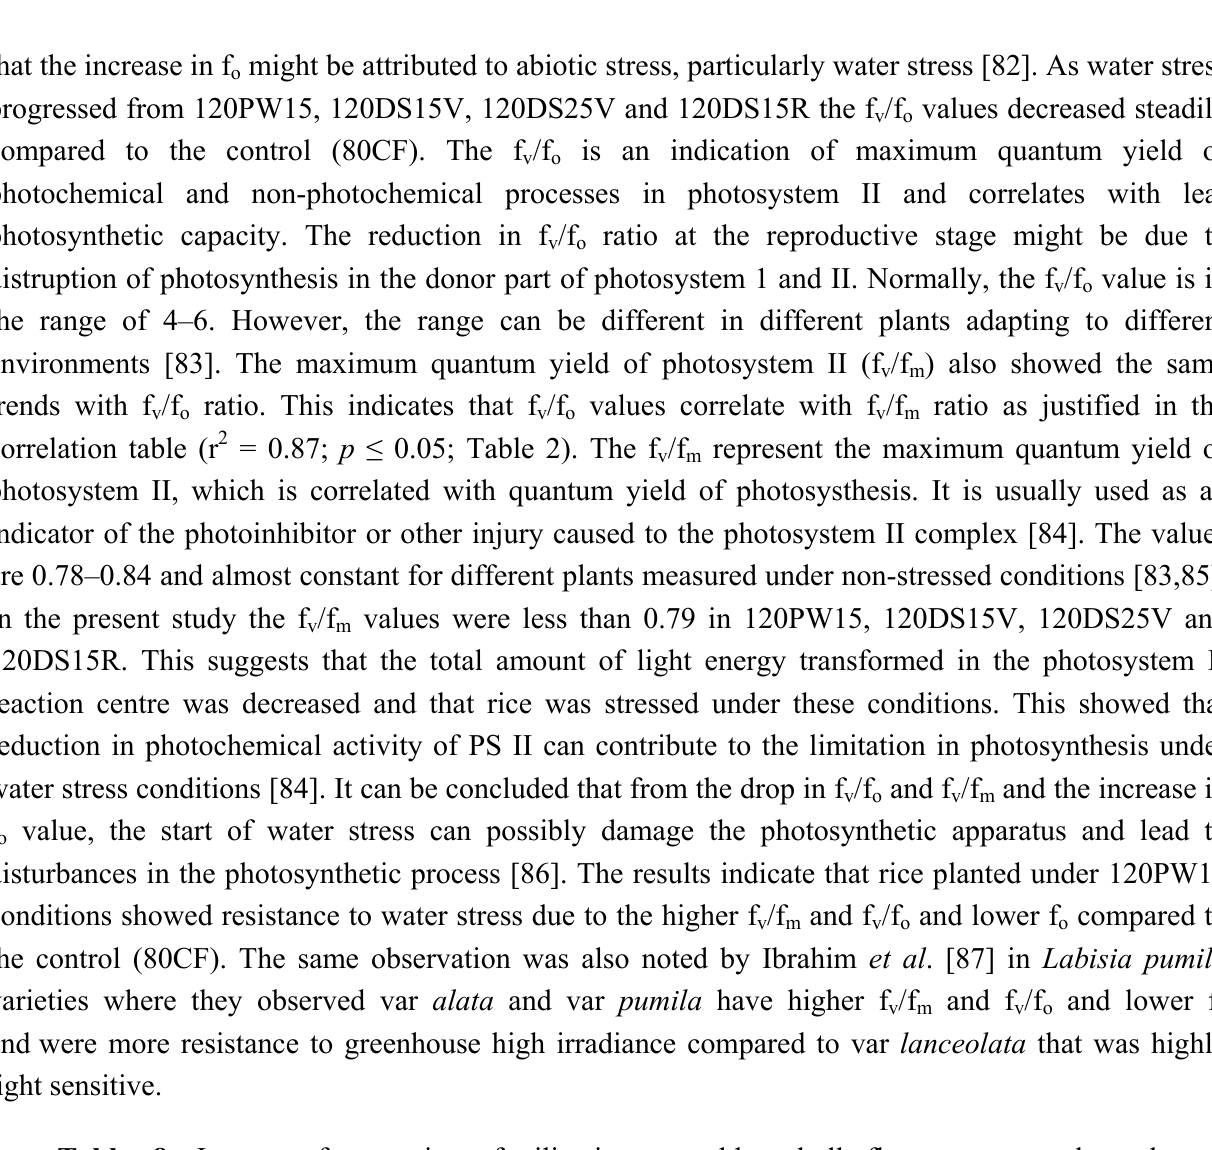
Table 8. Impact of potassium fertilization on chlorophyll fluorescence and total chlorophyll content under water stress at different growth stages of rice. Data are means ± standard error of differences between means (SEM). N = 12. Means not sharing a common single letter were significantly different at p ≤